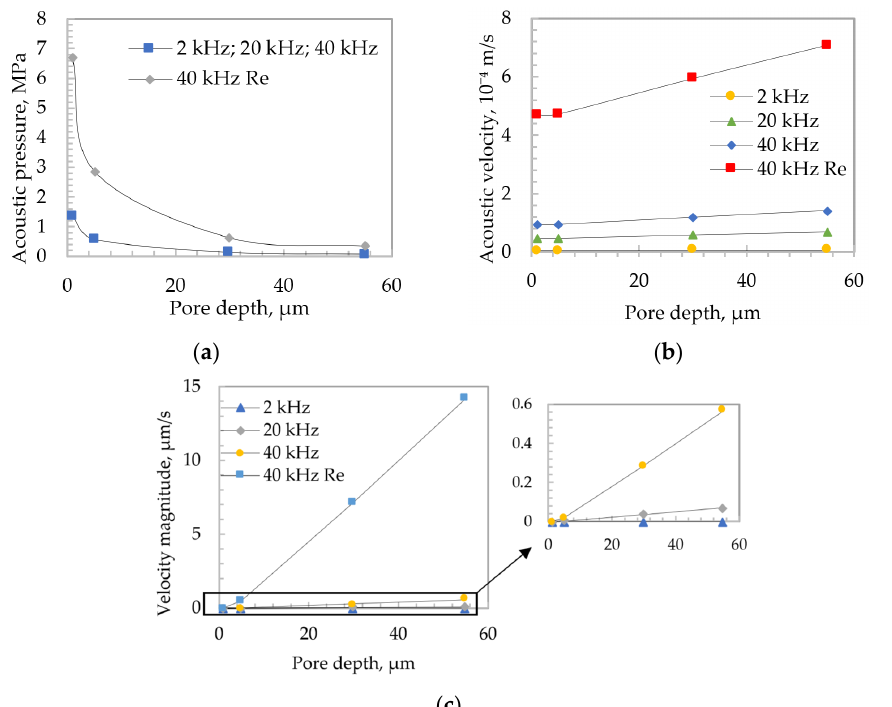
Figure 3. Comparative curves of different frequencies. ( a ) Acoustic pressure; ( b ) acoustic velocity; ( c ) velocity magnitude.